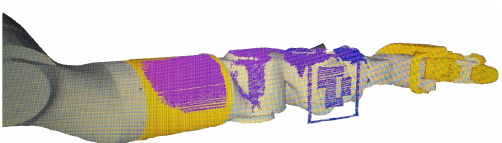
Figure 10. Eight DoF manipulator calibrated. It can be seen how the sensed point cloud overlays the six DoF